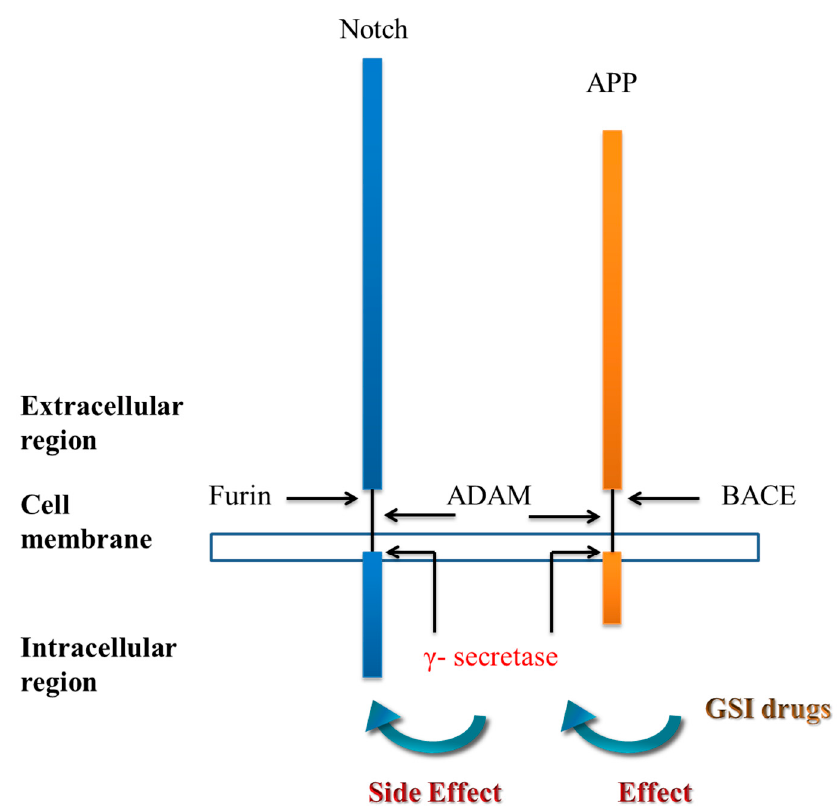
Figure 3. γ -secretase inhibitors. Notch and APP proteins are inactive when they are first synthesized and must have sections removed to become active. Furin and BACE first cleave these sections and activate the proteins. The second cleavage is by γ -secretase. GSIs can reduce γ -secretase but have a side effect of inhibiting Notch-signaling proteins. The function of this protein is related to nerve growth and differentiation. ADAM = A disintegrin and metalloproteinase, APP = amyloid precursor protein, BACE = beta-secretase, and GSI = γ -secretase inhibitors.